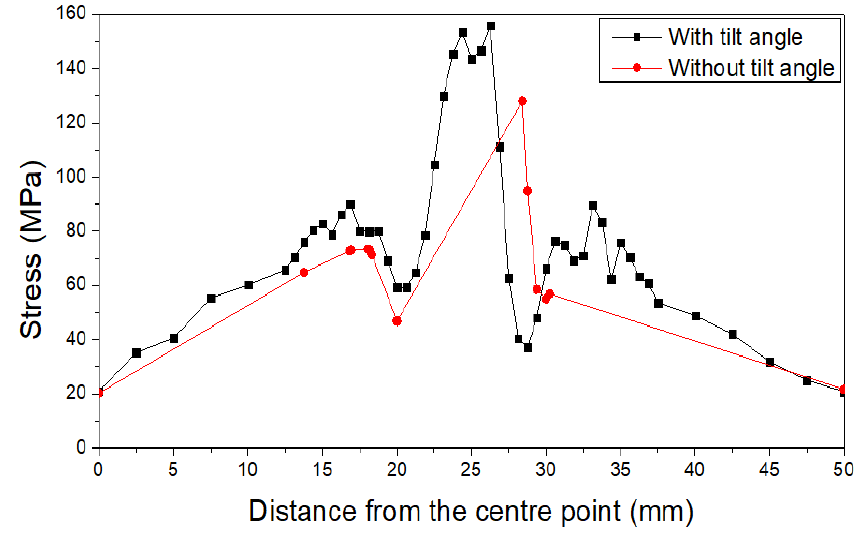
Figure 11. The cross-sectional view of the stress.